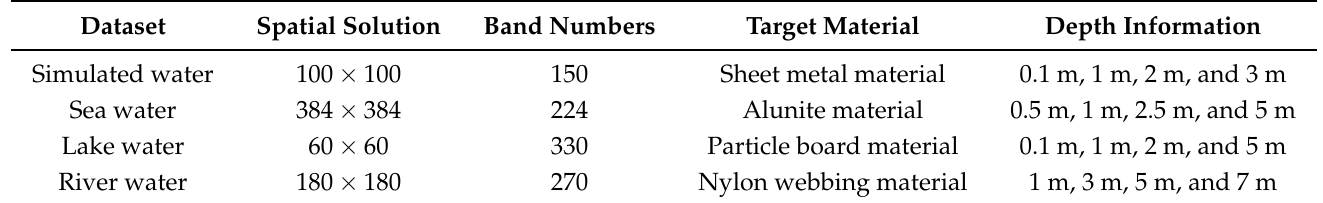
Table 1. The summary of the important information for all experimental